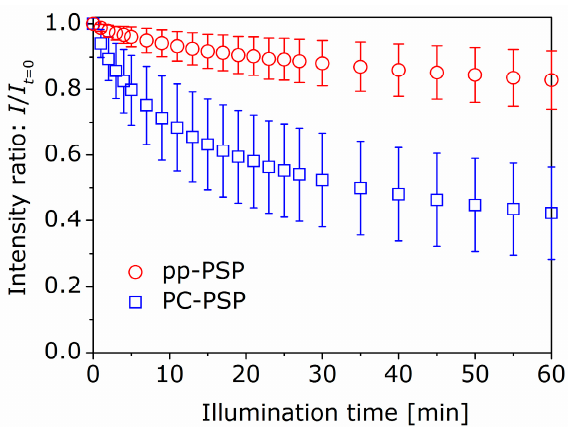
Figure 5. Relation between luminescent intensity and illumination time for pp-PSP and PC-PSP.